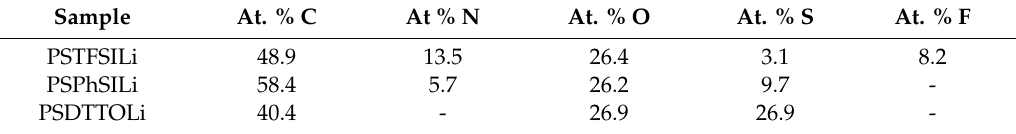
Figure 6. Energy dispersive x-ray spectroscopy (EDS) of the PSDTTOLi nanoparticles. Table 1. Elemental concentrations determined using the energy dispersive X-ray spectroscopy